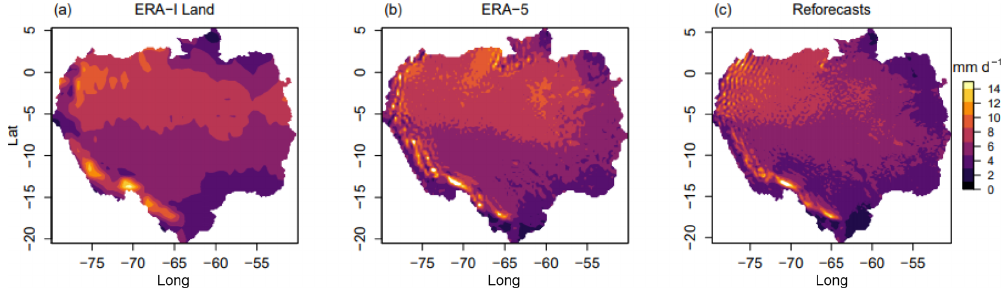
Figure 8. Mean daily precipitation totals throughout the Amazon basin. For (a) ERA-Interim Land, (b) ERA-5, and (c) the European Centre for Medium-Range Weather Forecasts (ECMWF) 20-year reforecasts. For the period